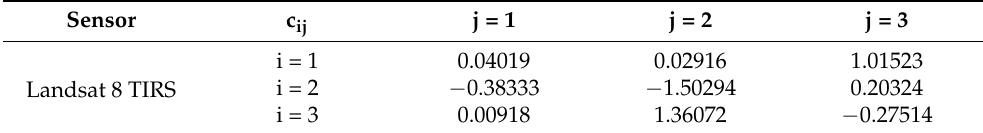
Table 3. The values of parameter c ij in the generalized single-window algorithm. Sensor c ij j = 1 j = 2 j = 3 i = 1 0.04019 Landsat 8 TIRS